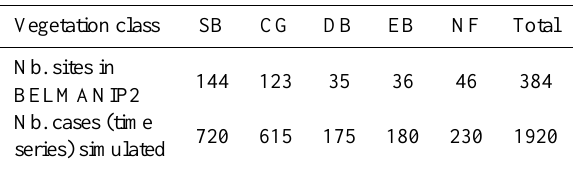
Table 3. Number of sites per vegetation class in BELMANIP2 set of sites, and number of cases considered in the gap simulation ex-